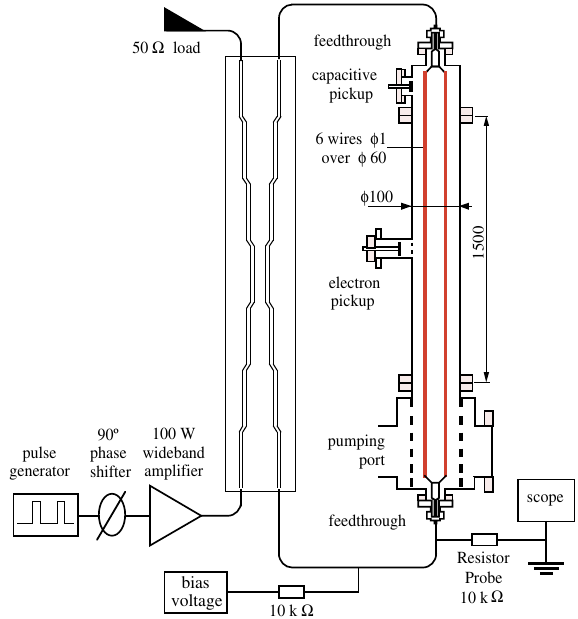
FIG. 4. (Color) Resonant ring outline. Pulses from the signal generator are amplified in the power amplifier and introduced into the wide band directional coupler. Part of the pulse is dumped at the end of one arm of the coupler into the rf load, while the other arm sends the induced signal to the chamber.